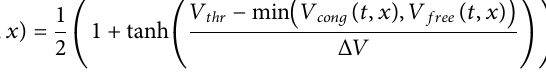
Frontiers in Future Transportation |